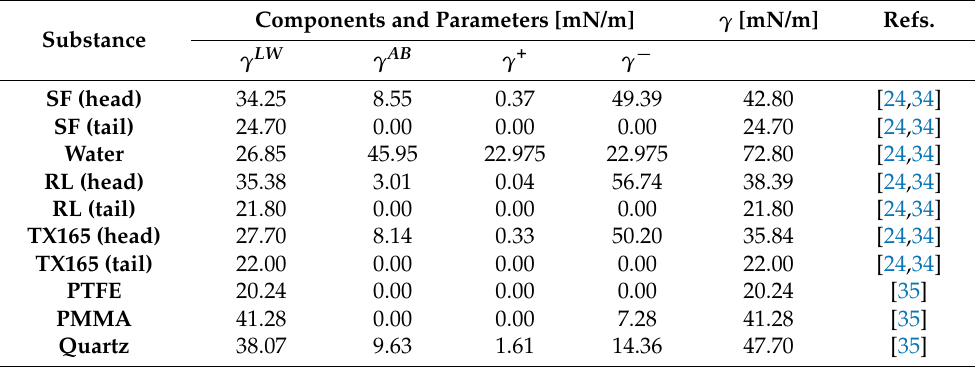
Table 1. The values of the Lifshitz-van der Waals ( γ LW ) and acid-base ( γ AB ) components as well as electron-acceptor ( γ + ) and electron-donor ( γ − ) parameters of water, TX165, rhamnolipid and surfactin head and tail as well as PTFE, PMMA and quartz surface tension ( γ ). Components and Parameters [mN/m] γ [mN/m] Refs. Substance γ LW γ